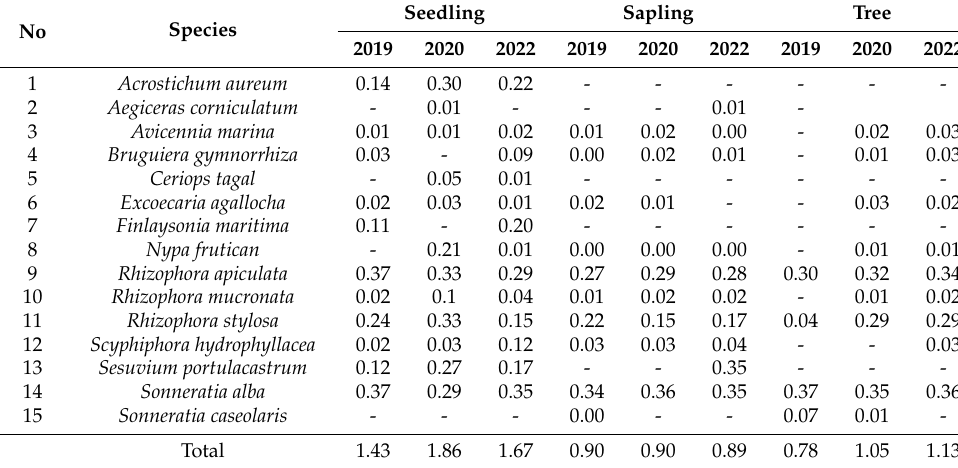
Table 7. Diversity (H (cid:48) ) observed in the restored areas planted with propagules surveyed between